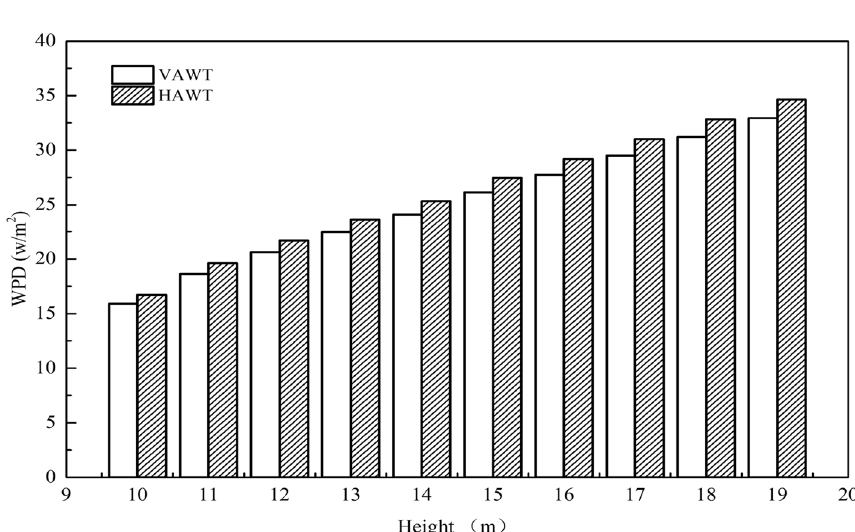
Figure 20. Annual wind density at each height.